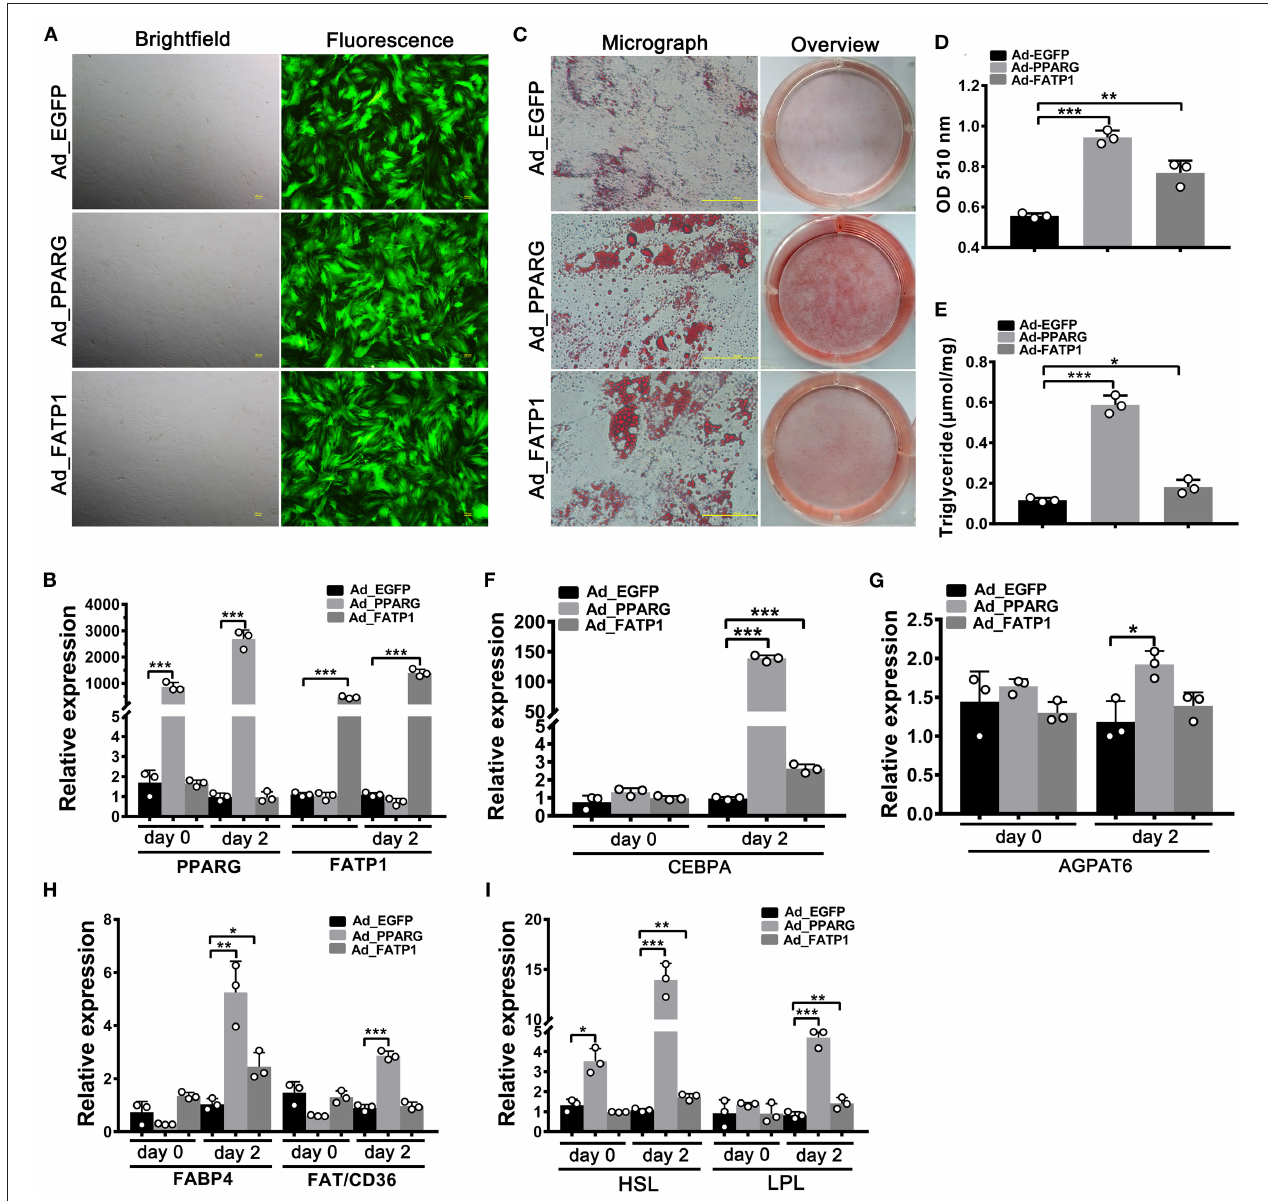
FIGURE 3 | The overexpression of FATP1 promotes adipogenic differentiation in buffalo intramuscular preadipocytes. (A) Micrographs of buffalo myocytes on day 2 of adenovirus transduction under bright and fluorescent light. Scale bar, 100 µ m. The mRNA expression levels of PPARG and FATP1 (B), the adipogenic gene CEBPA (F), the lipogenic gene AGPAT6 (G) , the fatty acid uptake-related genes FABP4 and FAT / CD36 (H), and the lipogenesis genes HSL and LPL (I) in the control and experimental groups on day 0 and day 2 of adipogenic trans-differentiation (2 and 4 days after adenovirus transduction, respectively). (C) Oil red O staining of “myocytes” on day 8 of adipogenic trans-differentiation. Scale bar, 100 µ m. (D,E) Quantification of lipid accumulation and triglyceride content in “myocytes” on day 8 of adipogenic trans-differentiation. EGFP overexpression (Ad_EGFP) served as a negative control; PPARG + EGFP overexpression (Ad_PPARG) served as a positive control; FATP1 + EGFP overexpression (Ad_FATP1) served as the experimental group. Data are presented as means ± SD, * p < 0.05, ** p < 0.01, *** p < 0.001.